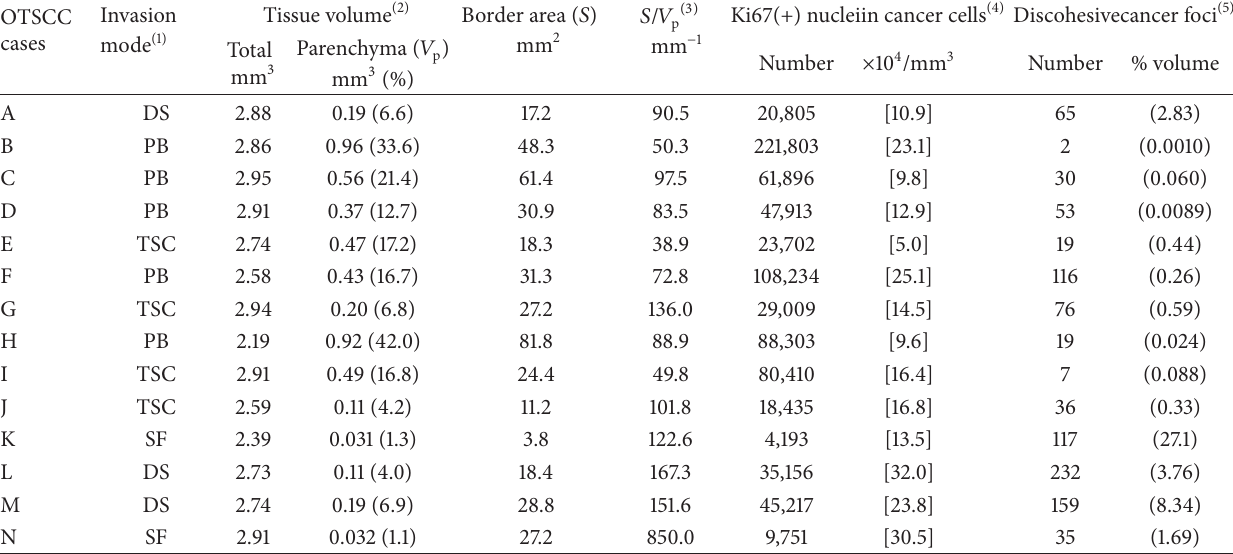
Table 2: Results of 3D morphometry of 14 OTSCC